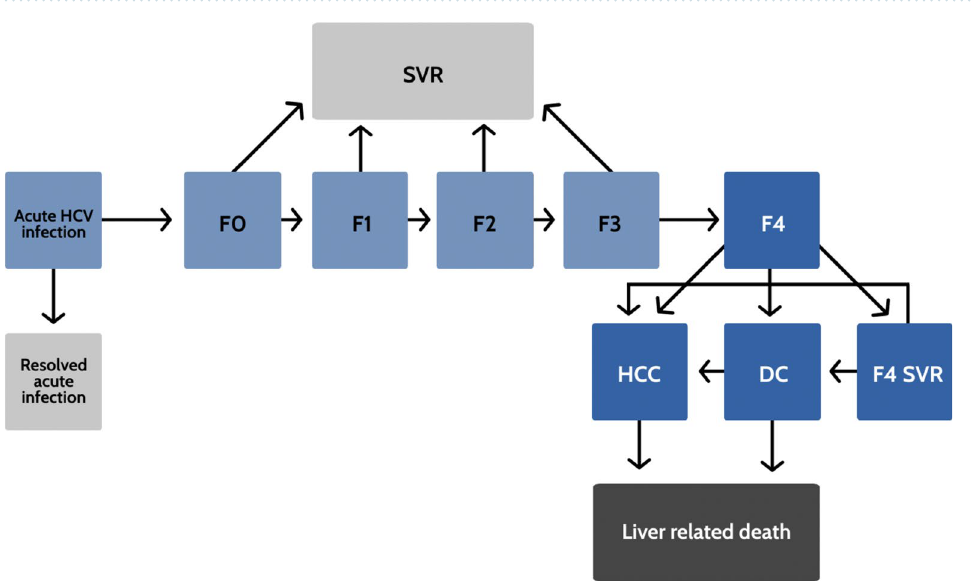
Figure 2. Model schematic of the natural history of hepatitis C virus in MATCH-Georgia model. Abbreviations: SVR, sustained virologic response; F0–F4, METAVIR fibrosis score; DC, decompensated cirrhosis; HCC, hepatocellular carcinoma; F4-SVR, sustained virologic response achieved at fibrosis stage